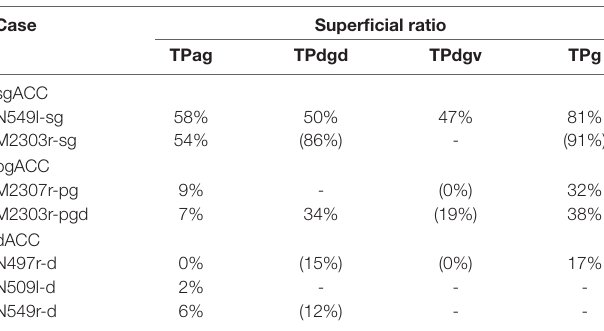
TABLE 3 | Superficial ratios in subregions of the